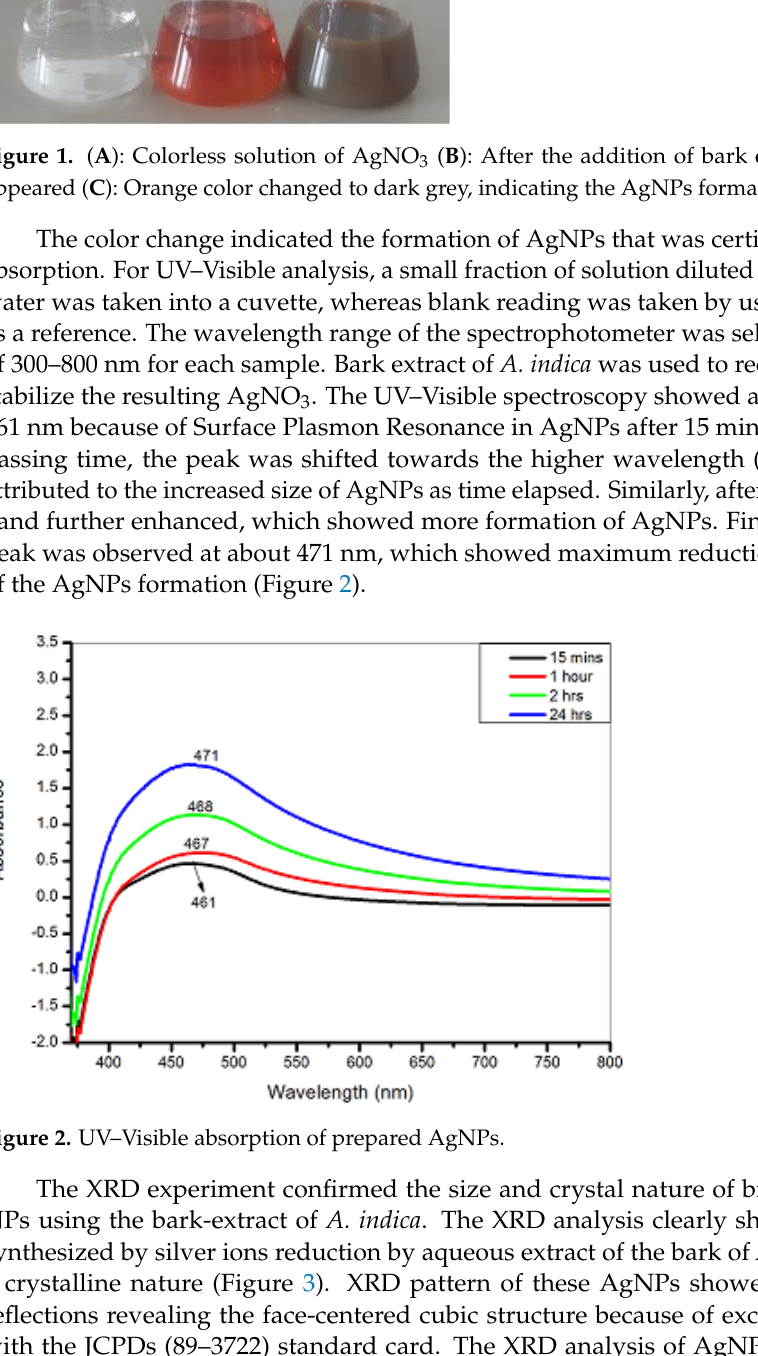
Figure 1. ( A ): Colorless solution of AgNO 3 ( B ): After the addition of bark extract, orange color ap- peared ( C ): Orange color changed to dark grey, indicating the AgNPs formation.